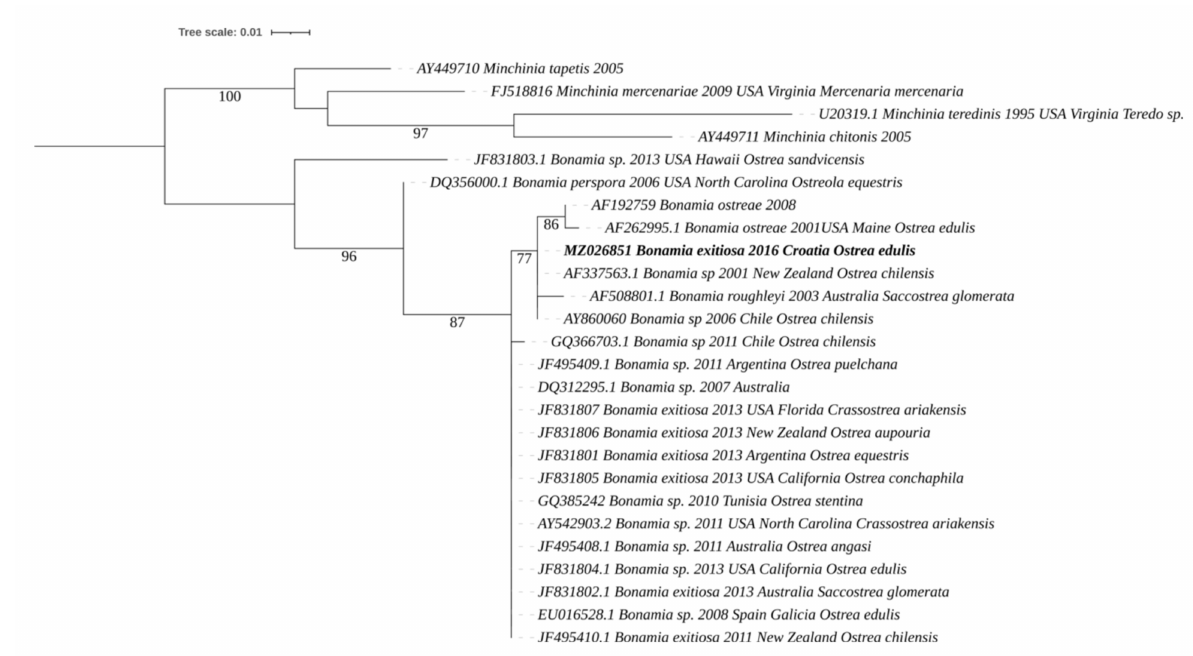
Figure 4. Bonamia spp. maximum likelihood phylogenetic tree. Bootstrap values higher than 75 are